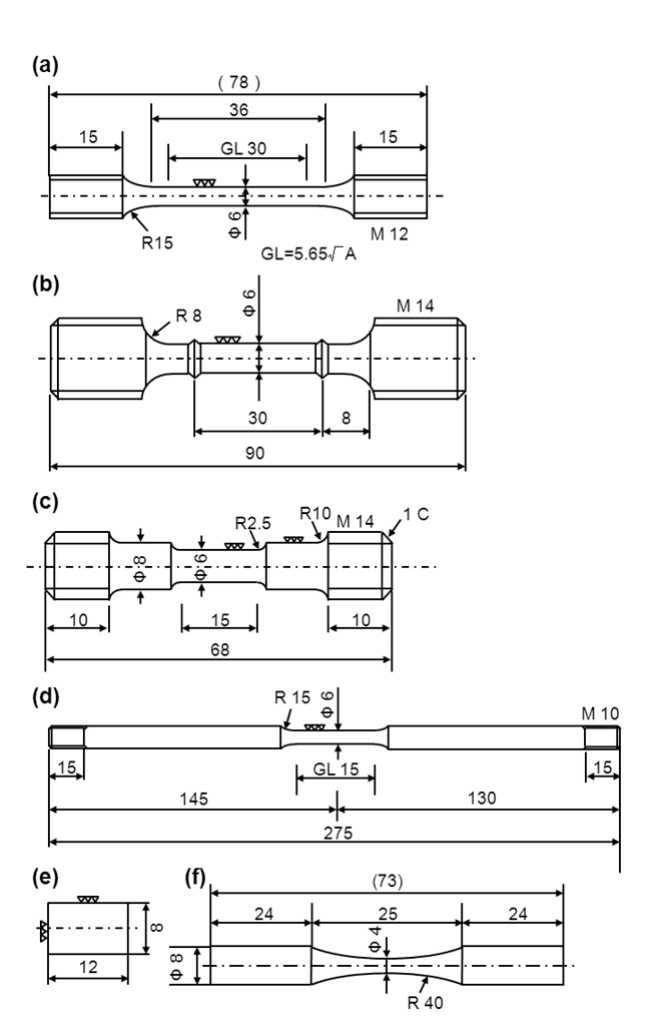
Figure 3. Dimensions of specimens for various mechanical tests. ( a )